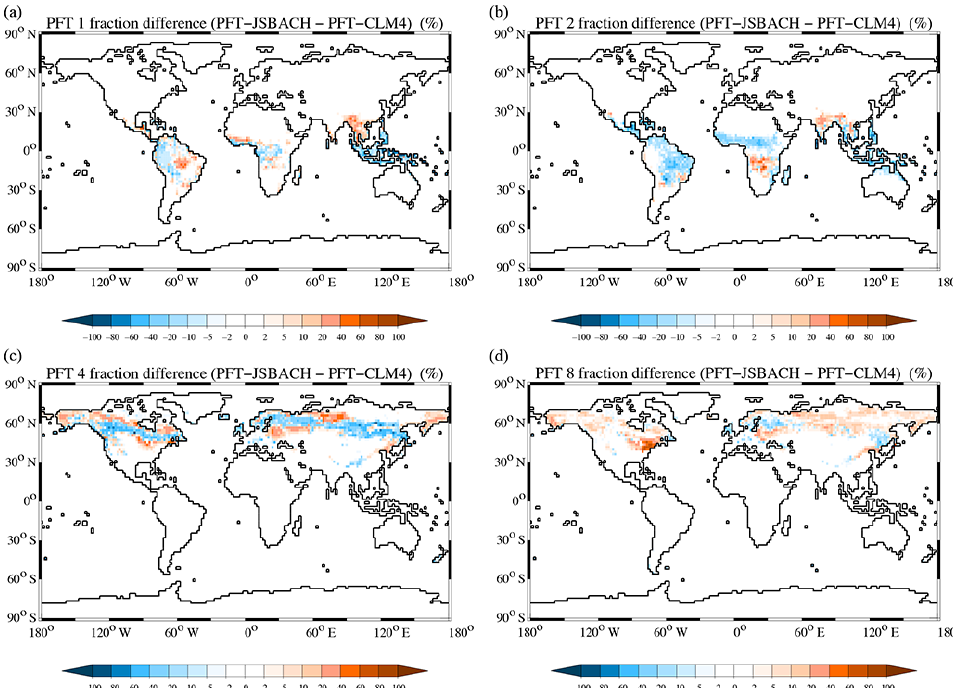
Figure 10. Difference between the extended-JSBACH PFT and the corresponding MEGAN2.1-CLM4 PFT distributions (cover fraction in %) for (a) broadleaf evergreen tropical trees, (b) broadleaf deciduous tropical trees, (c) needleleaf evergreen boreal trees, and (d) broadleaf deciduous boreal